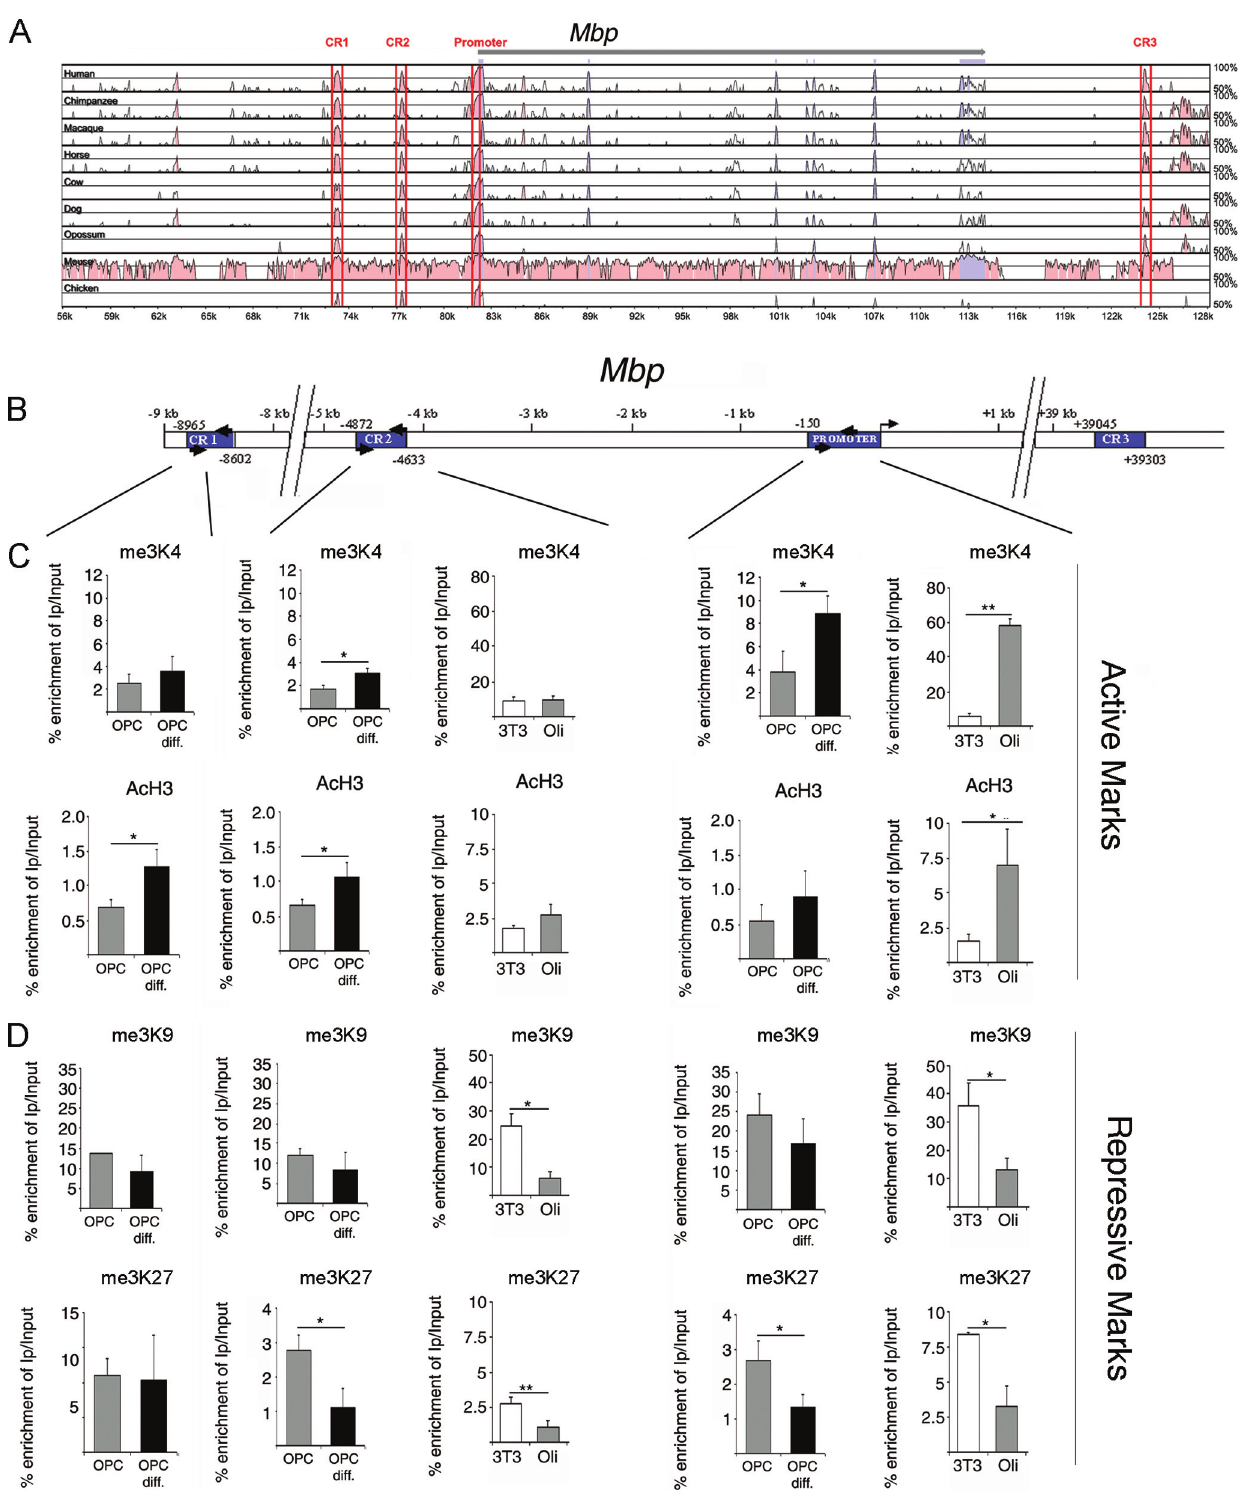
Figure 2. Comparison of the chromatin regions at the Mbp locus between oligodendrocyte progenitors and fibroblasts. Comparative sequence analysis of conserved (pink) and transcribed (blue) regions of the Mbp promoter in different animal species (A). Schematic representation of conserved regulatory regions (blue boxes) of the Mbp promoter (B). Comparative ChIP analysis of samples isolated from NIH3T3, Oli neu cells (Oli), proliferating (OPC) and differentiating (OPC diff) oligodendrocyte progenitors (C). Histone modifications in the different Mbp promoter regions were assessed by immunoprecipitating chromatin with antibodies specific for the activating histone marks (me3K4H3 and AcH3) (C) or for repressive histone modifications (me3K9H3 and me3K27H3) (D). The Mbp locus was characterized by permissive histone marks in oligodendrocyte progenitors and non-permissive marks in fibroblasts. ChIP was performed on five separate cultures. Results are expressed as mean 6 standard deviation (SD) and statistically analyzed using two tailed Student’s t tests (*p , 0.05, **p , 0.01). doi:10.1371/journal.pone.0013023.g002 PLoS ONE |